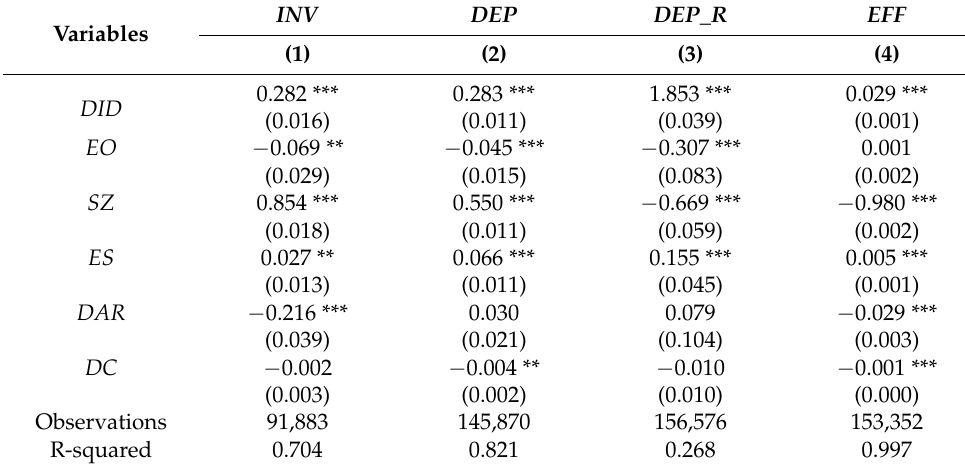
Table 4. Regression results of the capital renewal test.